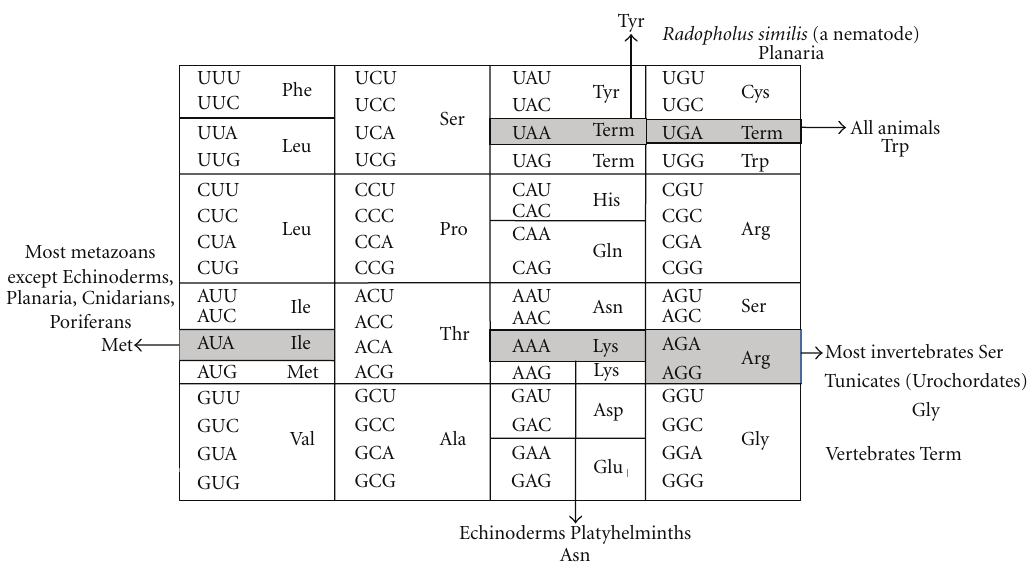
Figure 1: Universal genetic code (inside the box) and variations in animal mt genetic code (outside). Term: termination codon.